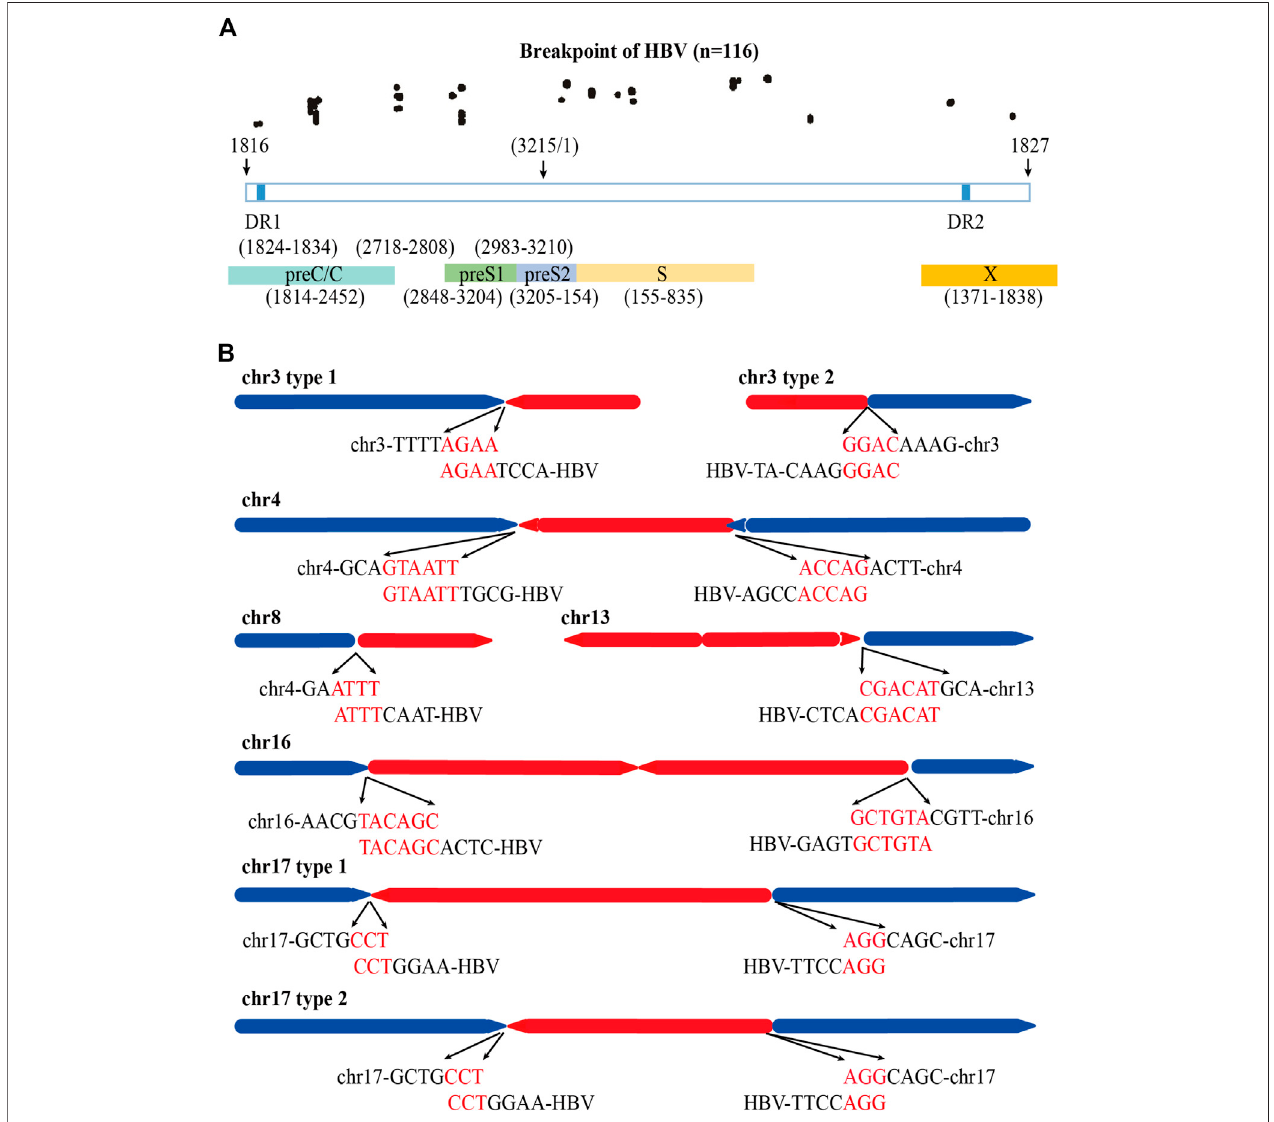
FIGURE 4 | Distribution of HBV integration fragment breakpoints and its homology with human chromosomes. (A) Distribution of HBV integration fragment breakpoints in HBV genome. (B) Homology analysis of virus-host junction sequences in HBV integration events. The red line represents the HBV genome, the blue line represents the human genome, the direction of the arrow represents the direction of the sequence, and the red words represents microhomology connections of HBV DNA and human genome.